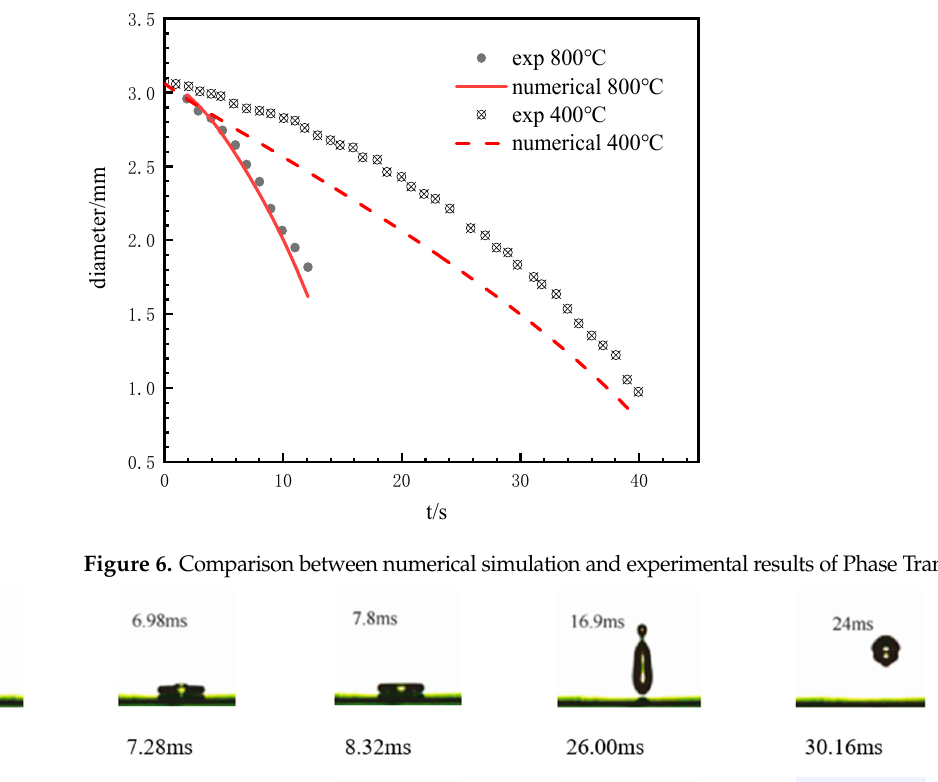
8 of 22 Figure 5. Comparison of grids with different encryption grades. 3.2. Numerical Model Verification 3.2.1. Comparison with Experimental Results Verification of Phase Transition Model Experimental data obtained by Volkov et al. [26] were used to verify the numerical model. The experiment was conducted by taking into account the vaporization of a sus- pended water droplet with an initial diameter of about 3 mm in a hollow transparent sil- icon glass cylinder with a radius of 0.1 m. A hot air fan was located below the cylinder that blew wind in an upward direction at 3~4.5 m/s. The initial diameter of the water drop was 3.06 mm at 30 ℃ temperature and the hot air at 400 ℃ and 800 ℃ , respectively, blew at speed of 3 m/s is considered for numerical simulation verification. The compared results are shown In Figure 6. It can be seen that the vaporization rate obtained by simulation is faster than that of the experiment, resulting in a sharp decrease in diameter of the droplet. However, the variation pattern of the diameter obtained from